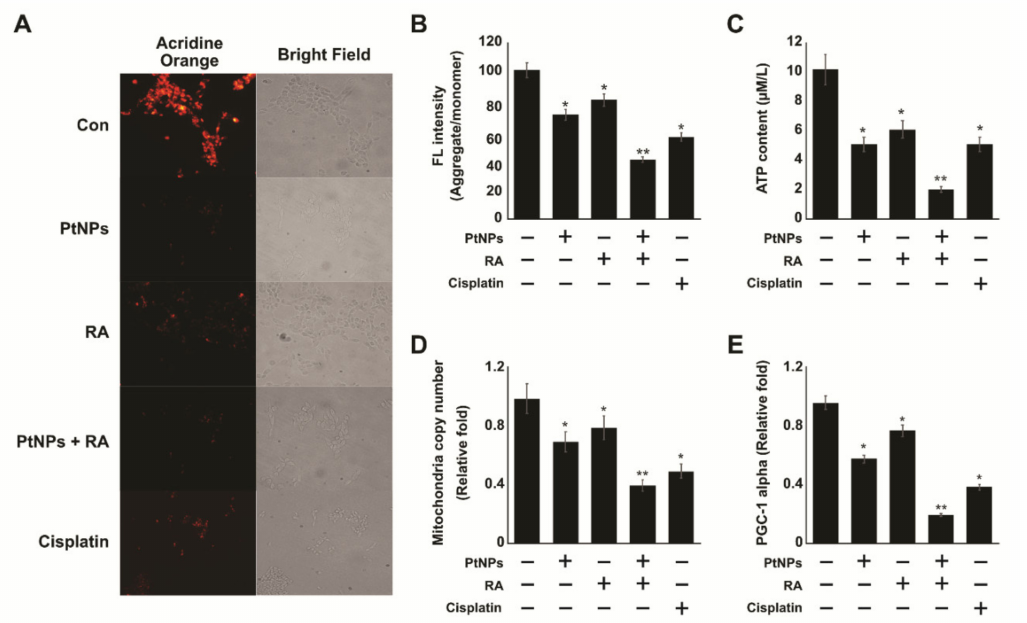
Figure 8. PtNPs and RA alter mitochondrial membrane potential (MMP), ATP content, mitochondrial copy number, and PGC1 α expression. SH-SY5Y cells were incubated with PtNPs (25 µ g / mL), RA (12.5 µ M), combination of PtNPs (25 µ g / mL) and RA (12.5 µ M), or cisplatin (6.5 µ M) for 24